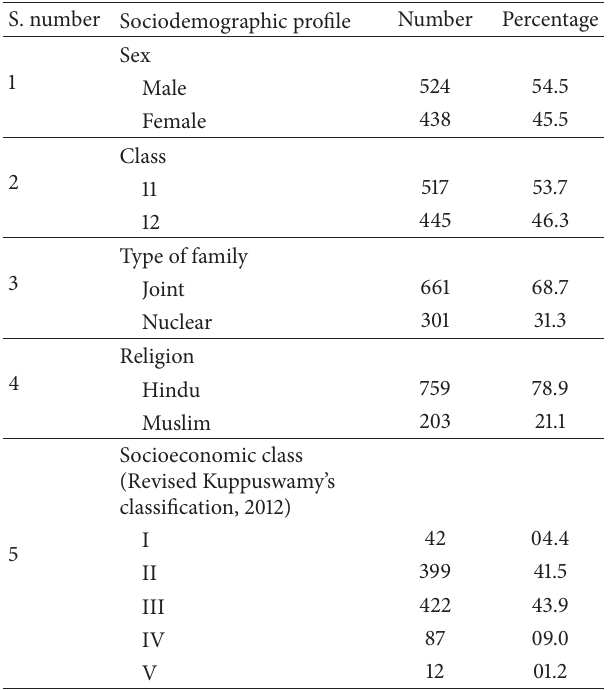
Table 1: Distribution of study participants according to sociodemo- graphic profile ( 𝑁 = 962